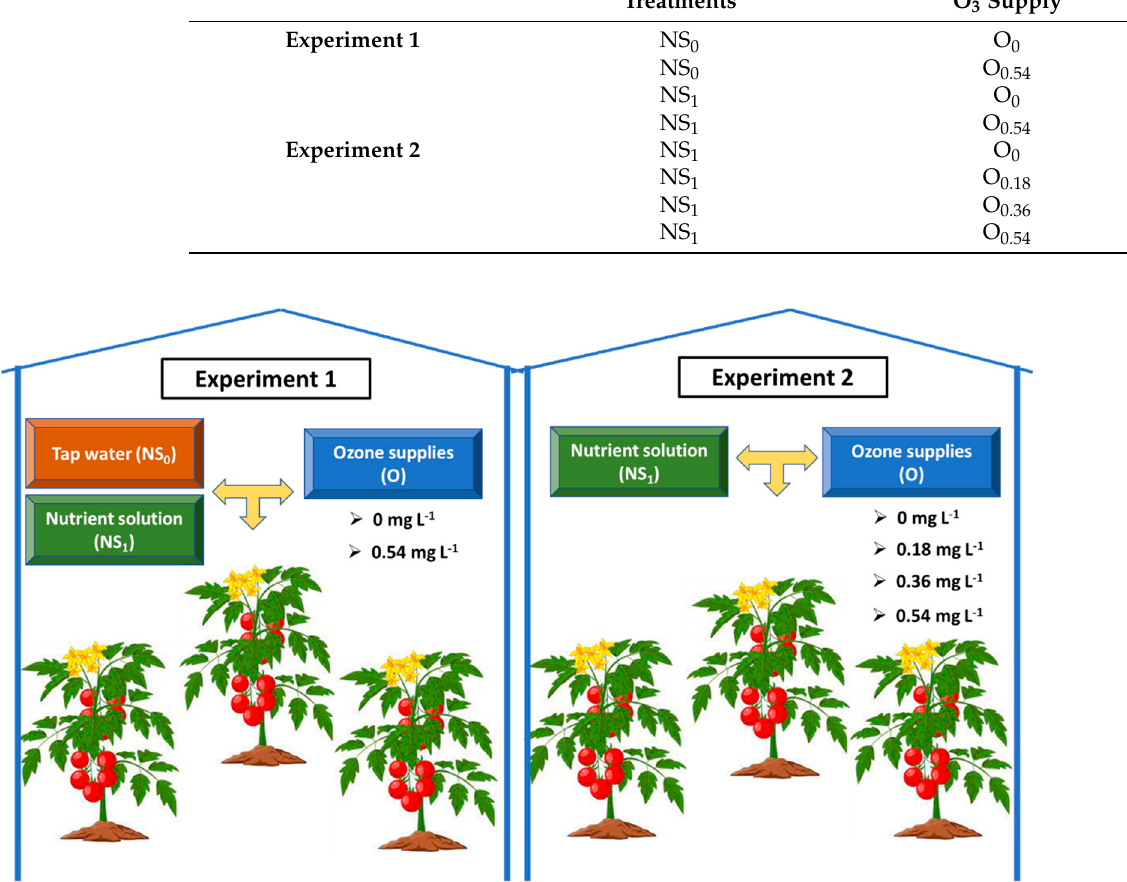
Table 2. Chemical composition of the tap water and nutrient solution (NS) after ozone saturation with the values of electrical conductivity (EC) (dS m − 1 ) and macronutrients concentration (mmol L − 1 ).